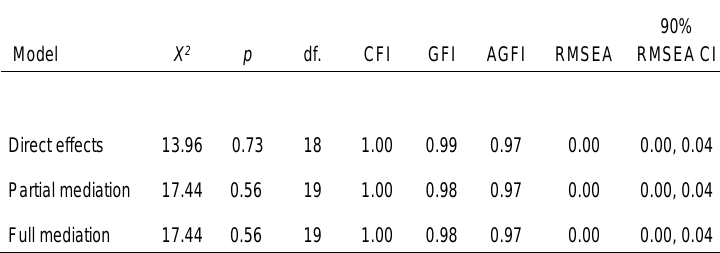
Table 2: Fit indices for each mediation model test (spirituality as mediator)